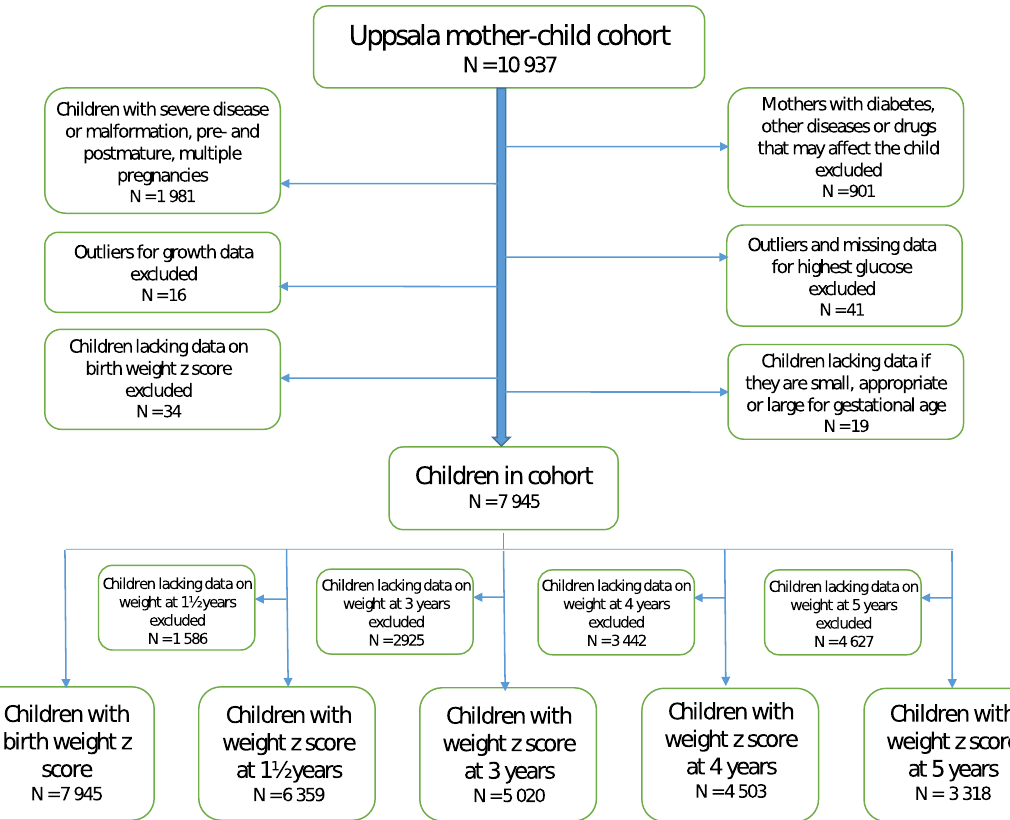
Figure 1. Study population. Flowchart shows causes and numbers of excluded observations and number of observations in the final study population. Number of mother–child dyads with a value of weight z-score at birth, 1½, 3, 4 and 5 years of age are found at the bottom of flow